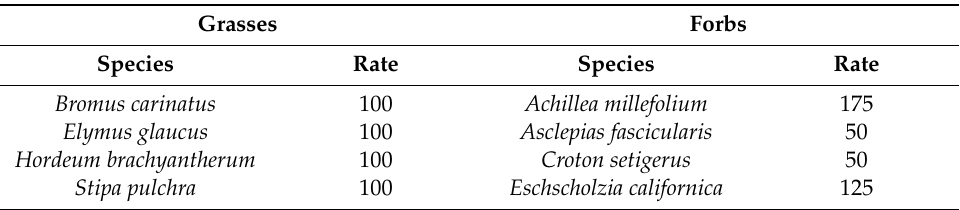
Table 1. Seeding rates (live seed / m2) for seeded grasses and forbs. Grasses Forbs Species